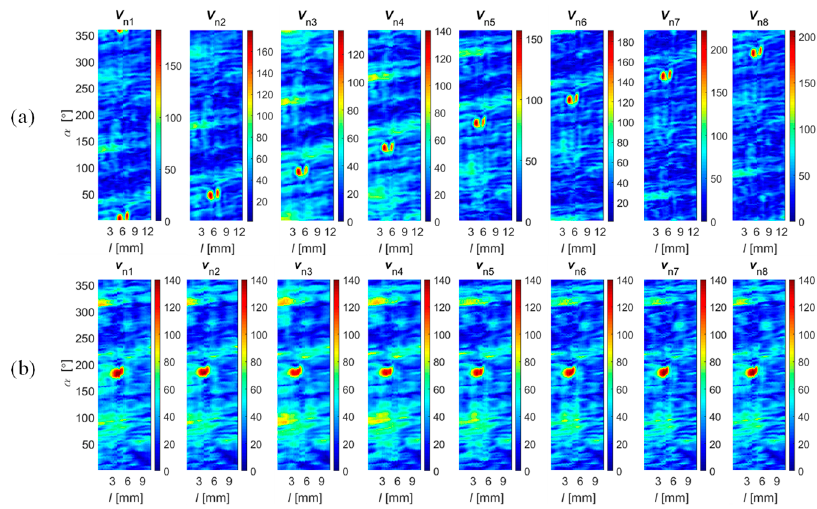
Figure 8. Distributions of field V n and v n norm sensed by successive sensors obtained for 0.5 mm Figure 8. D istributions of field V n and v n norm sensed by successive sensors obtained for 0.5 mm Figure 8. D istributions of field V n and v n norm sensed by successive sensors obtained for 0.5 mm Figure 8. D istributions of field V n and v n norm sensed by successive sensors obtained for 0.5 mm depth circumferential defect ( d 4 ) over 2-D scanning area ( l , α ): ( a ) before and ( b ) after the registration depth circumferential defect ( d 4 ) over 2-D scanning area ( l , α ): ( a ) before and ( b ) after the registration depth circumferential defect ( d 4 ) over 2-D scanning area ( l , α ): ( a ) before and ( b ) after the registration depth circumferential defect ( d 4 ) over 2-D scanning area ( l , α ): ( a ) before and ( b ) after the registration process; unit: 100 equals 0.4 G. process; unit: 100 equals 0.4 G. process; unit: 100 equals 0.4 G. process; unit: 100 equals 0.4 G.